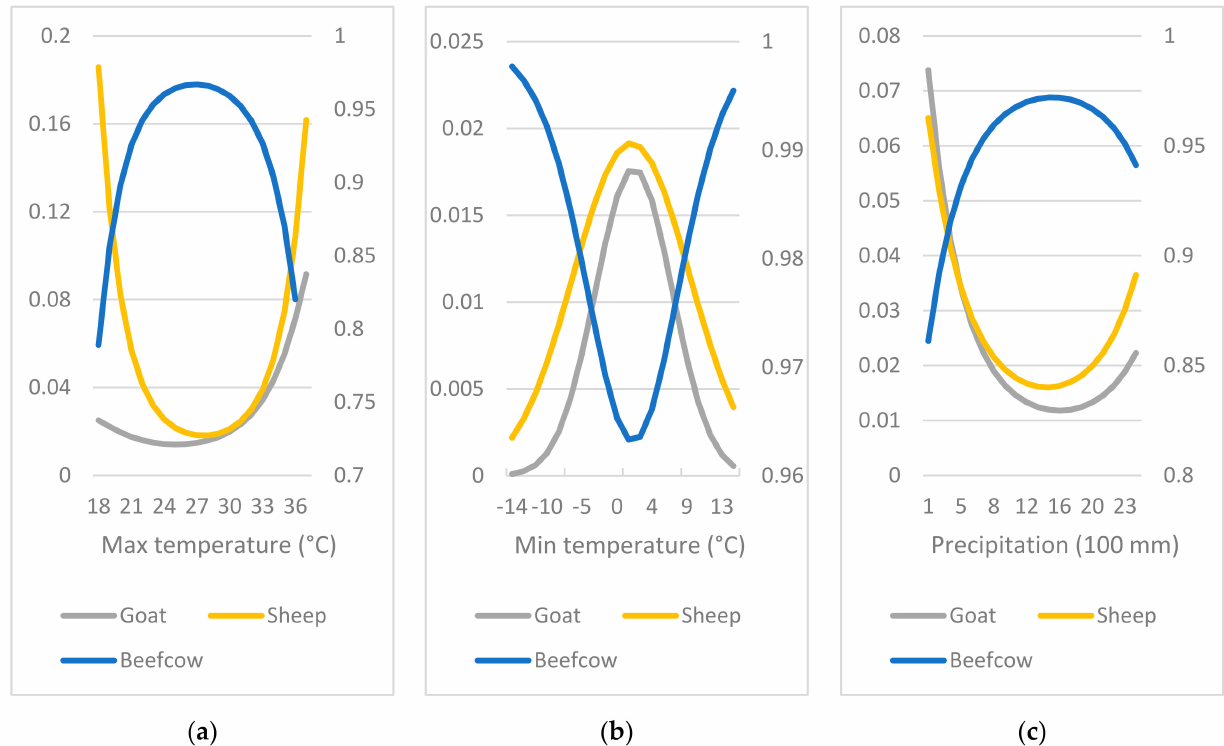
Figure 3. Average marginal effect of climate variables on land shares in the west: ( a ) Maximum Temperature; ( b ) Minimum Temperature; ( c )